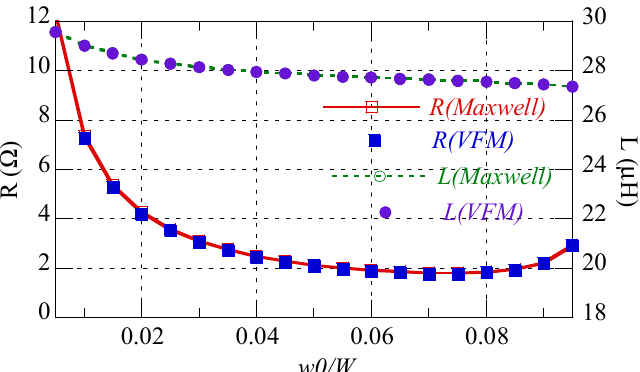
Figure 4. Comparison between the calculations and simulations of ohmic resistance and self-inductance for W = 30 mm, t = 2 oz, f = 6.78 MHz, and N = 10.